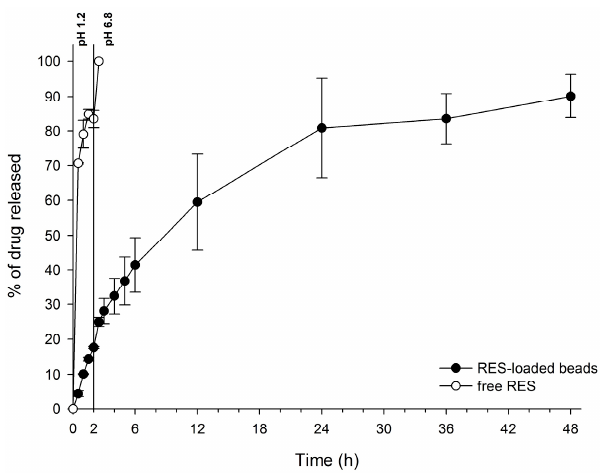
Figure 2. Dissolution profile of RES (free and loaded in GG:P beads) in media that mimic gastric (1.2) and enteric pH (6.8) ( n = 3; mean ± SD).